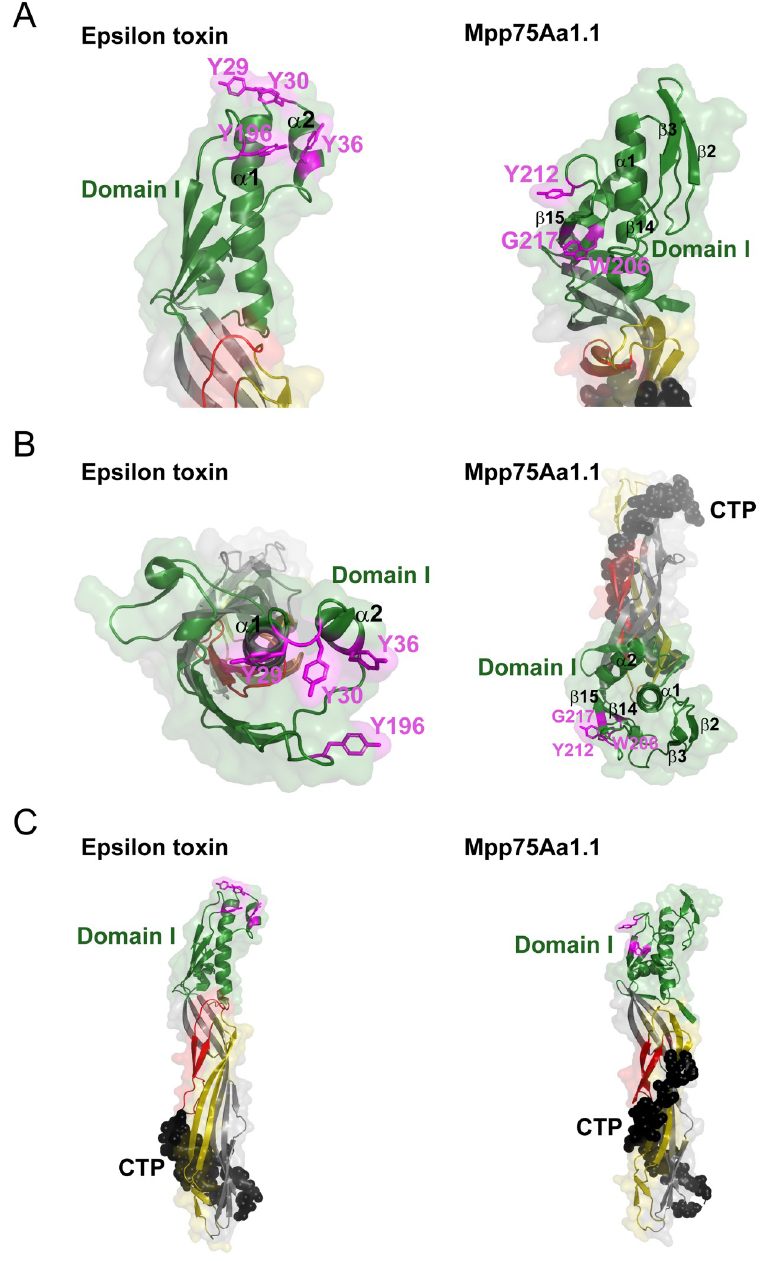
Fig 3. Structural comparison of Mpp75Aa1.1 and Epsilon toxin (ETX). (A) Head-to-head comparison between Mpp75Aa1.1 and ETX receptor binding domain, highlighting key residues. Domain I residues are shown in green and in cartoon representation; key residues are highlighted in magenta using sticks representation. (B) Top-down view of Mpp75Aa1.1 and ETX along the longitudinal axis of helix α 1, highlighting potential key receptor binding epitopes, and additional domains in the full-length proteins. Domain I residues are shown in green cartoon representation. Domains II and III residues are indicated in red, yellow, and grey colors in cartoon representation, which correspond to strands that comprise the membrane-inserted pore (red), pore extension (yellow) and outer barrel (grey) portion in the membrane-inserted β -hairpin of these proteins; the color assignment was based on the available sequence and structural homology of Mpp75Aa1.1. Key receptor binding residues are highlighted in magenta using sticks representation. (C) The ETX and Mpp75Aa1.1 structure highlighting the C-terminal peptide residues in black spheres including the seven-residue C-terminal his-tag. Domain I residues are shown in green and in cartoon representation. Domain II and III residues are indicated with red, yellow and grey colors in cartoon representation, corresponding to strands that comprise the membrane-inserted pore (red), pore extension (yellow) and outer barrel (grey) portion in